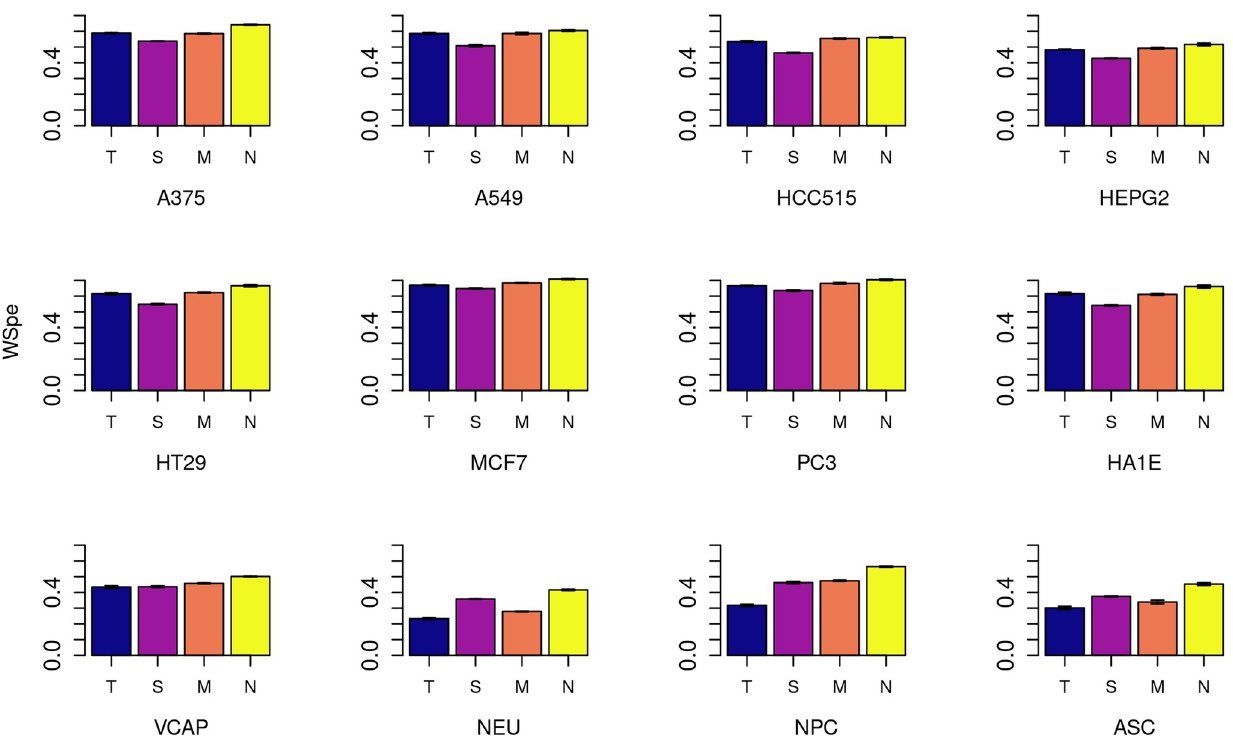
Fig 3. Positive connectivity results. Weighted Spearman rank correlation (WSpe) scores for positive connectivity across all genes and drugs, for each of the 12 cell lines in the complete data set. Methods are denoted by single-letter labels: T: Tissue-agnostic; S: SVD; M: Median of medians; N: Neighborhood collaborative